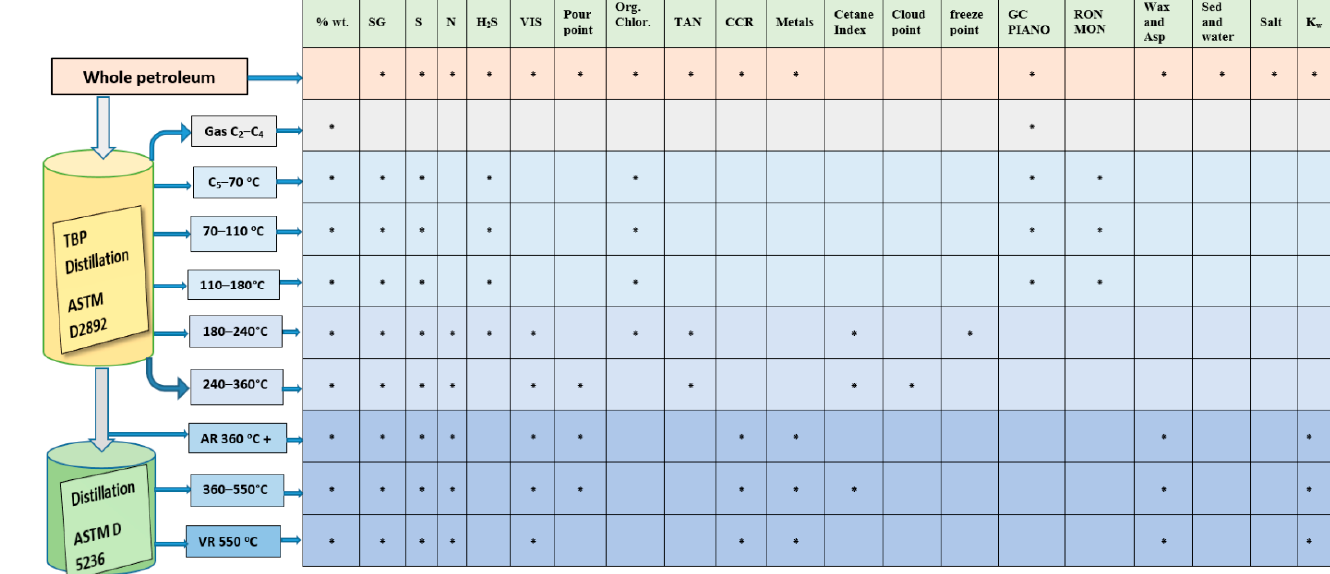
Figure 2. Typical analysis scheme of petroleum characterization by means of crude oil assay. Note: The sign • means performance of measurement of the property shown in the first row of the table of Figure 2.